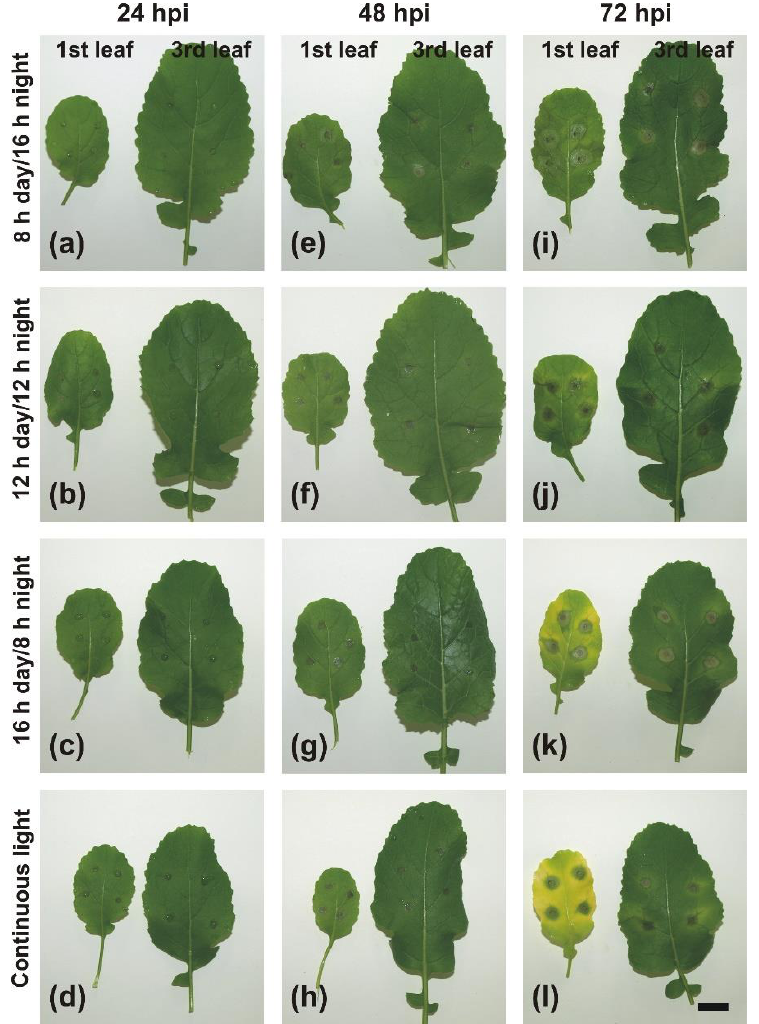
Figure 3. Time-course of the phenotypic response of the 1st and 3rd B. juncea leaf to A. brassicicola infection. Plants were grown and infected under different day-length regimes, simultaneously: ( a , e , i ) 8 h day/16 h night; ( b , f , j ) 12 h day/12 h night; ( c , g , k ) 16 h day/8 h night; and ( d , h , l ) continuous light, examined 24 ( a – d ), 48 ( e – h ), and 72 ( i – l ) hours post-inoculation (hpi). The presented images were taken in a single experiment. The 1st leaf is the oldest. Scale bar = 20 mm.